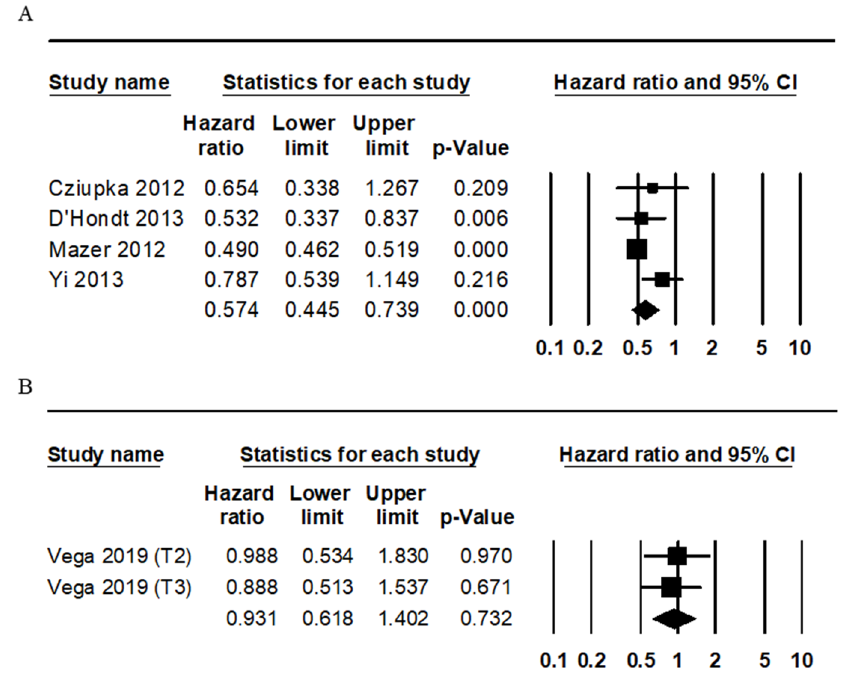
Figure 2. Forest plots for the di ff erences of the survival rates between incidental gallbladder cancer (IGBC) and non-IGBC. ( A ) Overall survival and ( B ) disease-free survival.